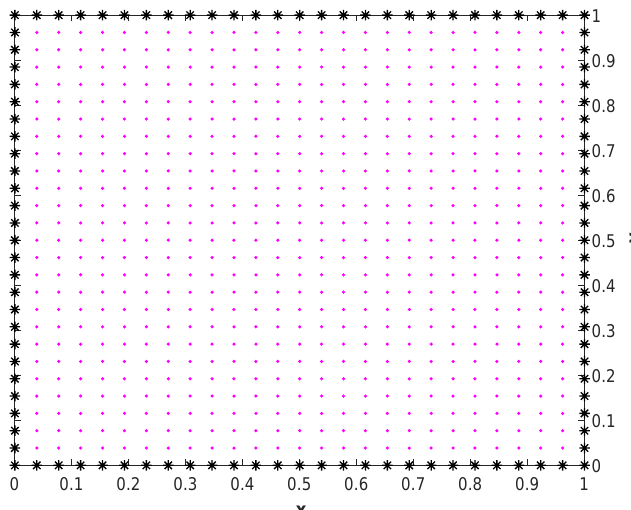
Figure 1. Node distribution in the square